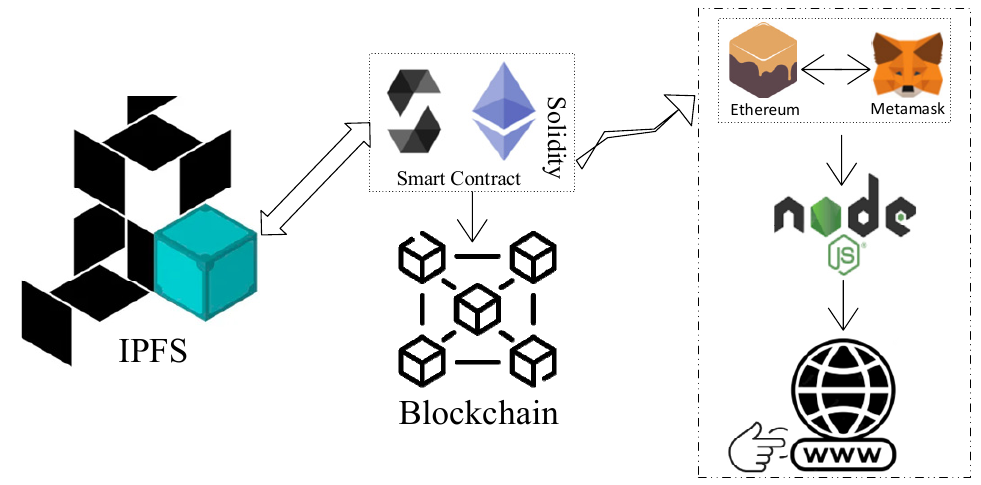
Figure 5. An illustration of technologies and tools for system implementation.